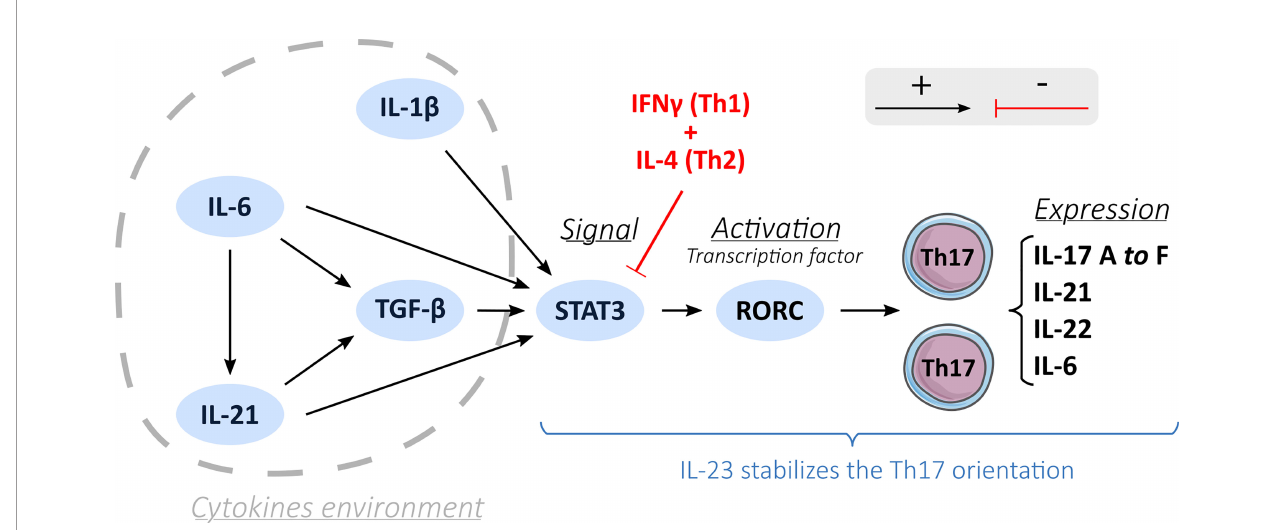
FIGURE 1 | Th17 differentiation process. A description of the Th17 orientation process through different activation factors (black arrows): cytokines environment, induction by STAT3 and activation by a transcription factor RORC and the inhibition of the Th17 orientation process by the Th1 and Th2 cells (red arrows). IL-23 stabilizes the Th17